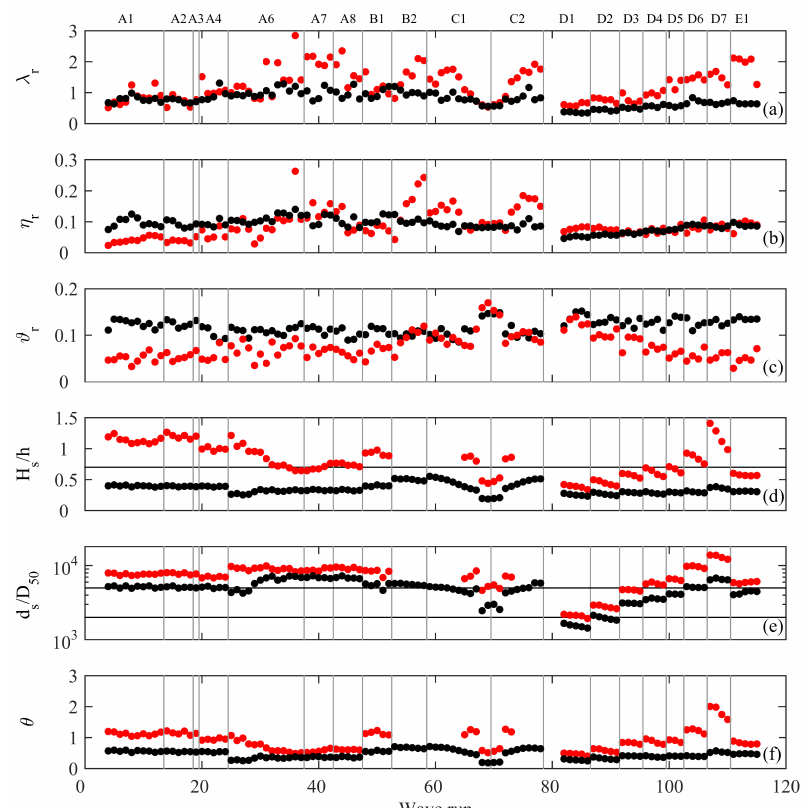
Figure 6. Temporal evolution of ( a ) ripple length λ ; ( b ) ripple height η ; ( c ) ripple steepness r r ϑ /h ; ( e ) normalized orbital diameter d /D ; ( d ) relative wave height H and ( f ) Shields r s s 50 parameter at x = 55 (black dots) and 80 m (red dots). The cross-section ripple data in ( a )–( c ) are based on a 10-m wide window centered at each x . The vertical grey lines in each panel mark the transition between tests. Note that the horizontal axis corresponds to the cumulative number of wave runs. Because runs were of different duration, the horizontal axis is not equidistant with time. The horizontal line in ( d ) marks the approximate transition /h = 0 . 7 ). The two horizontal lines in between non-breaking and breaking conditions ( H s /D = 2000 and 5000 ; [11,13]) to delineate the orbital, ( e ) are previously defined values ( d s 50 suborbital and anorbital ripple regimes. No values at x = 80 m are shown in ( d )–( f ) for B2 and for several C1 and C2 wave runs because the instrument was not submerged continuously during these low h s